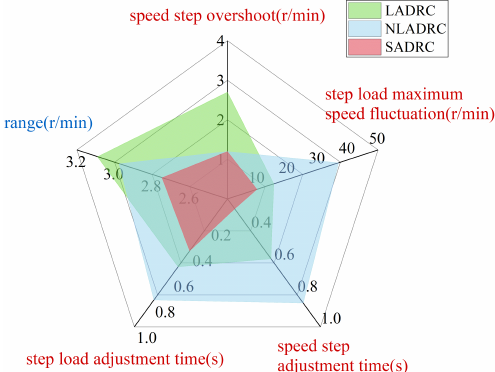
Figure 13. Comprehensive performance comparison of the LADRC, NLADRC and